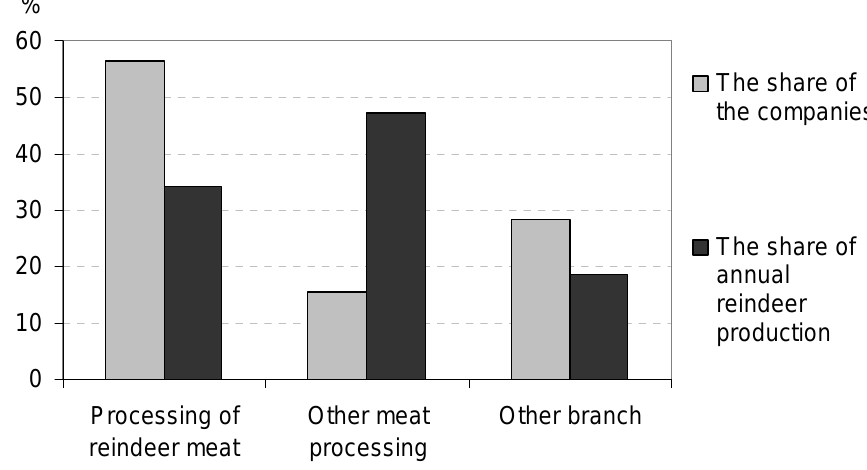
Fig. 1. Processors divided by main line of business and reindeer meat production.